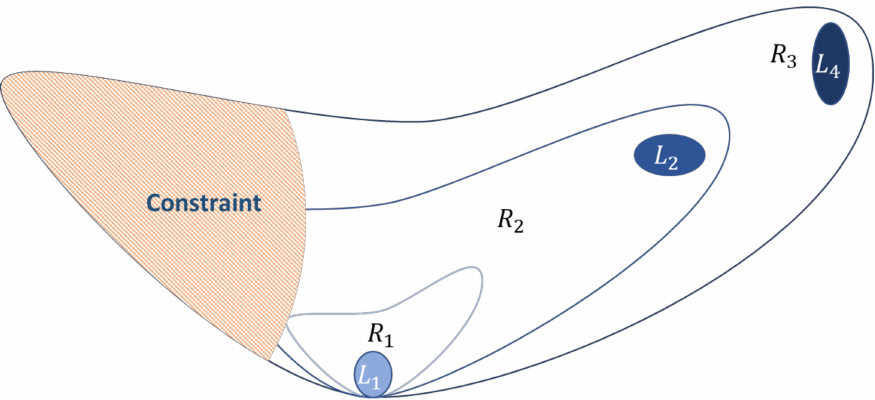
Figure 2. Schematic representation of the possible search spaces ( R 1 , R 2 , and R 3 ) of a given function with L 1 , L 2 , and L 4 as local minima and L 3 and L 5 as constrained